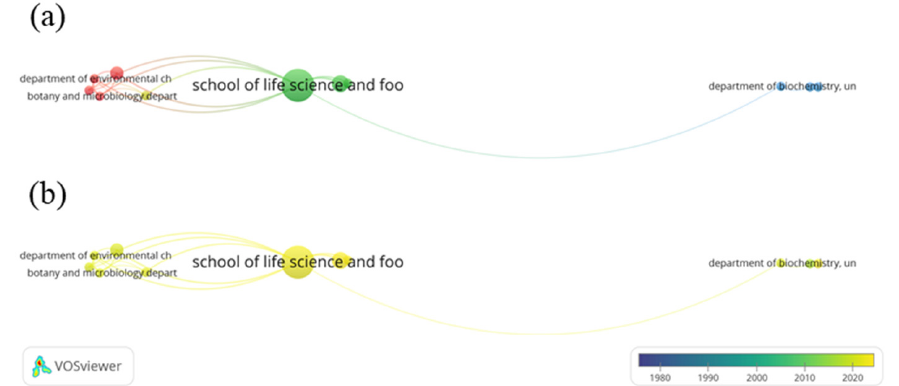
Figure 4. ( a ) Network visualization of organizations’ co-authorship (weights: documents). ( b ) Overlay visualization of organizations’ co-authorship in 1978–2022 (weights: documents; scores: average publications per year). Only connected organizations were shown.